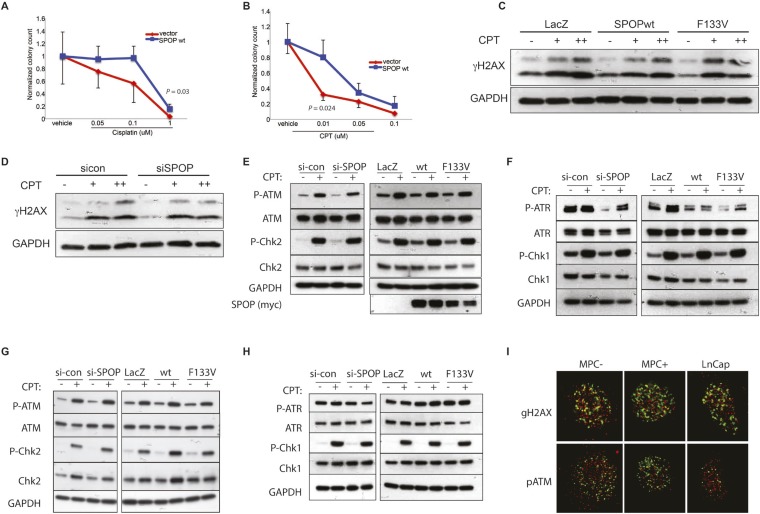
SPOP and response to DSB.(A, B) Clonogenic assay measuring survival of stable SPOP-expressing 22Rv1 cells after CPT or cisplatin treatment. (C) Western blot for the DSB marker γH2AX using protein lysates from RWPE cells before and after CPT treatment (30 min) in RWPE cells either ectopically expressing SPOP-wt or -F133V or (D) treated with control (sicon) or SPOP targeting siRNA (siSPOP). (E–H) Western blot for DNA damage signaling proteins using protein lysates from 22Rv1 (E, F) or RWPE (G, H) cells before and after CPT treatment (30 min). Cells either ectopically expressed SPOP-wt or SPOP-F133V or were treated with control (sicon) or SPOP-targeting siRNA (siSPOP). (I) Immunofluorescence-based partial colocalization of SPOP (red) and early DNA damage markers gH2AX or pATM (green). MPC-expressing Cre-inducible SPOP-F133V was transduced with tamoxifen-inducible Cre (CreERT2). MPC were treated with 4-OH tamoxifen or vehicle and exposed to ionizing radiation (3GY).